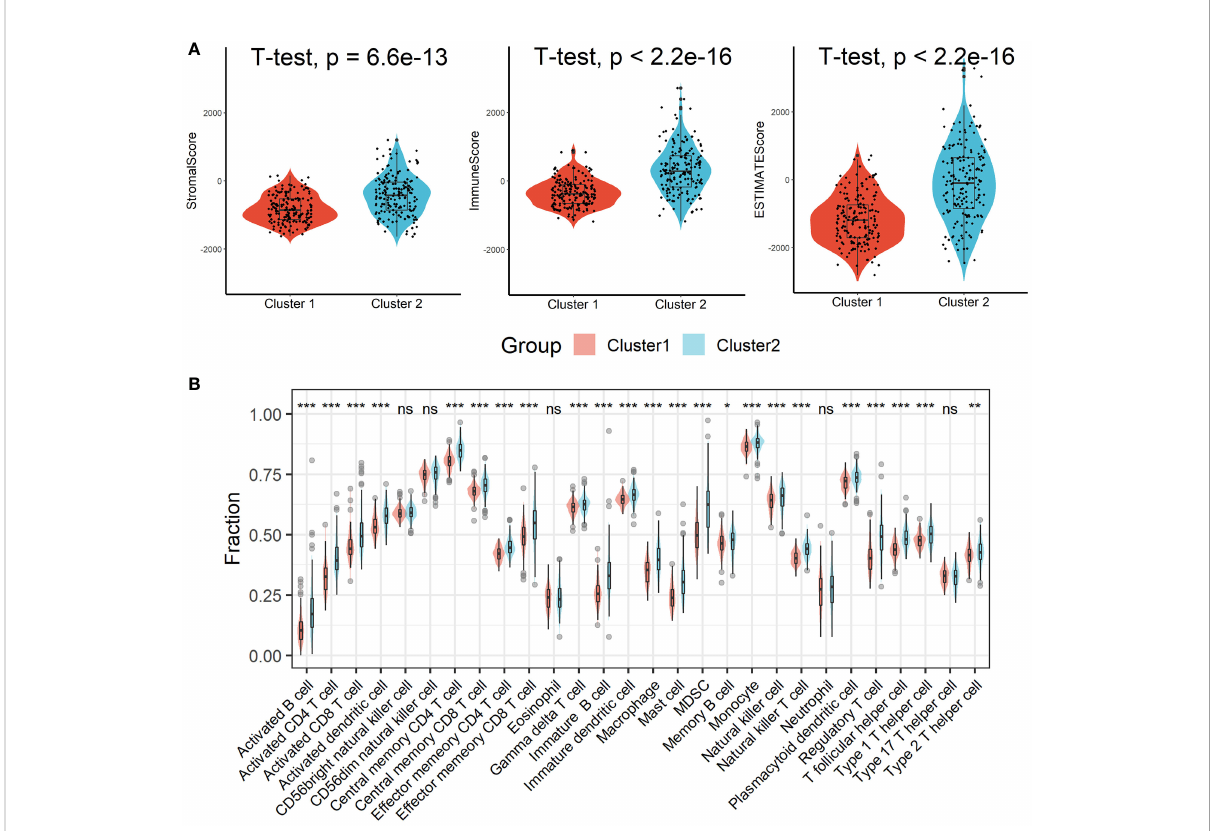
FIGURE 3 Estimation of immune cell in fi ltration in different clusters. (A) Patients in Cluster 2 had higher immune, stromal, and ESTIMATE scores compared with patients in Cluster 1. (B) Almost all types of immune cells were higher in Cluster 2 than those in Cluster 1 except for CD56bright natural killer cell, CD56dim natural killer cell, eosinophil, neutrophil, and Type 17 T helper cell. ns, not signi fi cant; *p < 0.05; **p <0.01; ***p <